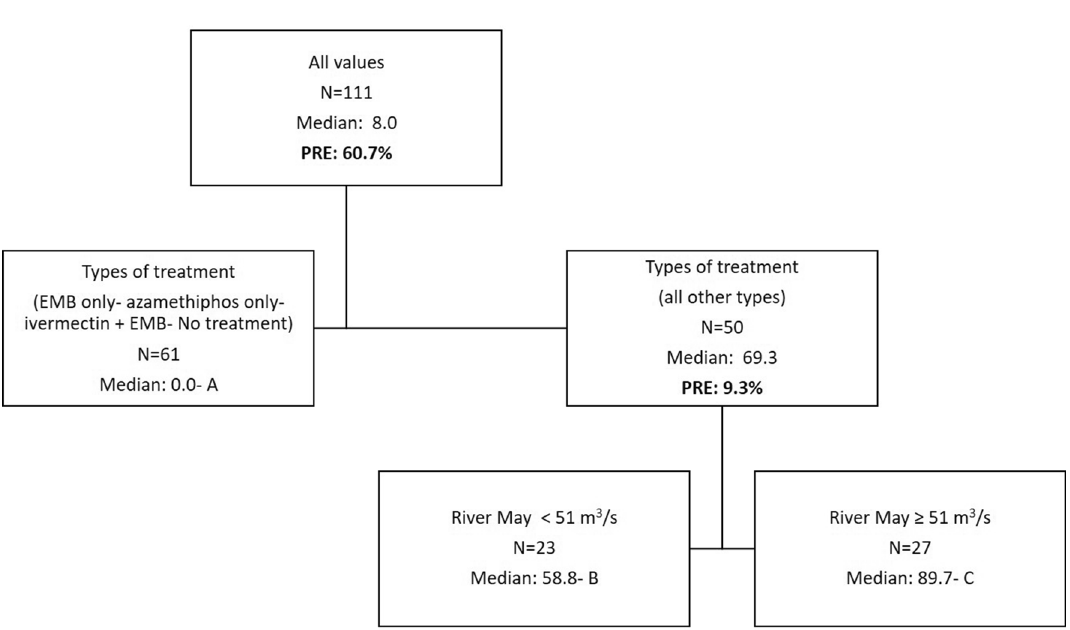
Figure 8. DTA with sums of normalized rates of multi-chemical usage as a dependent variable with a focus on salinity effects as per river influence. Predictors include: Bay, Company, usage of lumpfish, numbers of fish, types of treatment, stocking year, River monthly discharges (January to December i.e. 12 predictors). The total PRE of this tree is